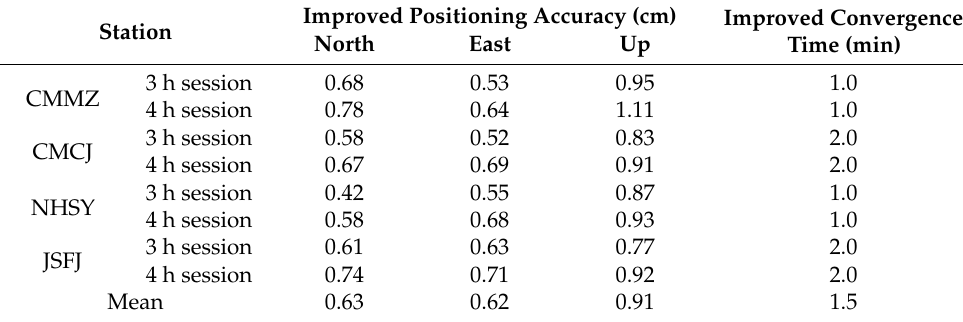
Table 4. Positioning accuracy and convergence time.